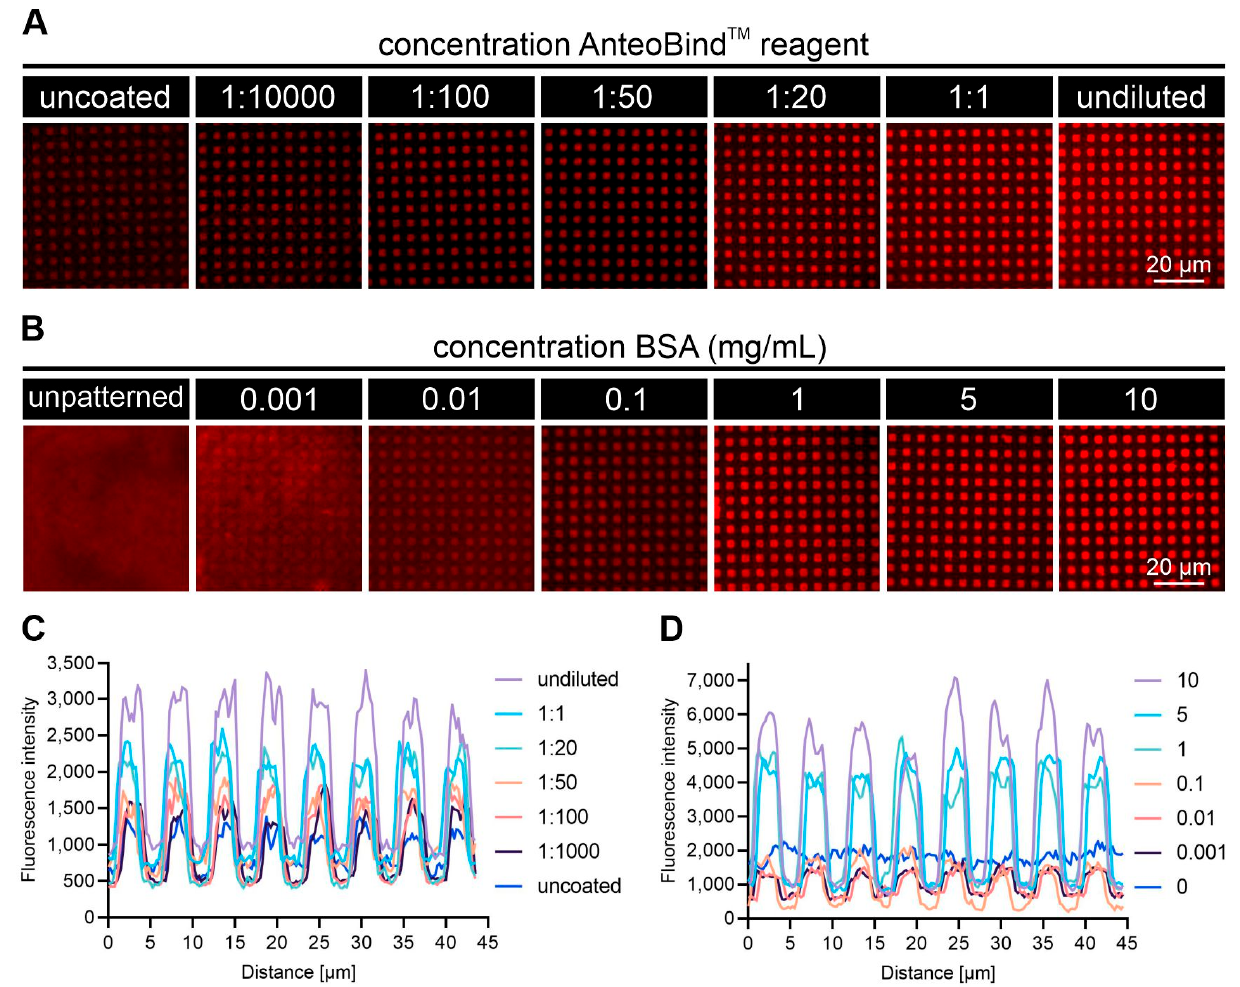
Figure 2. Characterization of AnteoBind TM coating for protein micropatterning via µ CP. ( A ) Glass substrates were precoated with indicated concentrations of AnteoBind TM reagent (diluted in ddH 2 O) prior µ CP with BSA-inked (5 mg/mL) PDMS stamps. BSA-patterned substrates were further modified with Cy5-labeled streptavidin (50 µ g/mL). Binding of STA-Cy5 to uncoated glass surfaces was used as control. ( B ) Glass substrates were precoated with AnteoBind TM reagent (1:20 in ddH 2 O) prior µ CP with BSA-inked (indicated BSA concentrations) PDMS stamps. BSA-patterned substrates were further modified with Cy5-labeled strep(tavidin (50 µ g/mL). Binding of STA-Cy5 to coated but unpatterned surfaces was used as control. ( C ) Representative line profiles of STA-Cy5 fluorescence signal at indicated AnteoBind TM dilution as shown in A. ( D ) Representative line profiles of STA-Cy5 fluorescence signal at indicated BSA concentration as shown in B.